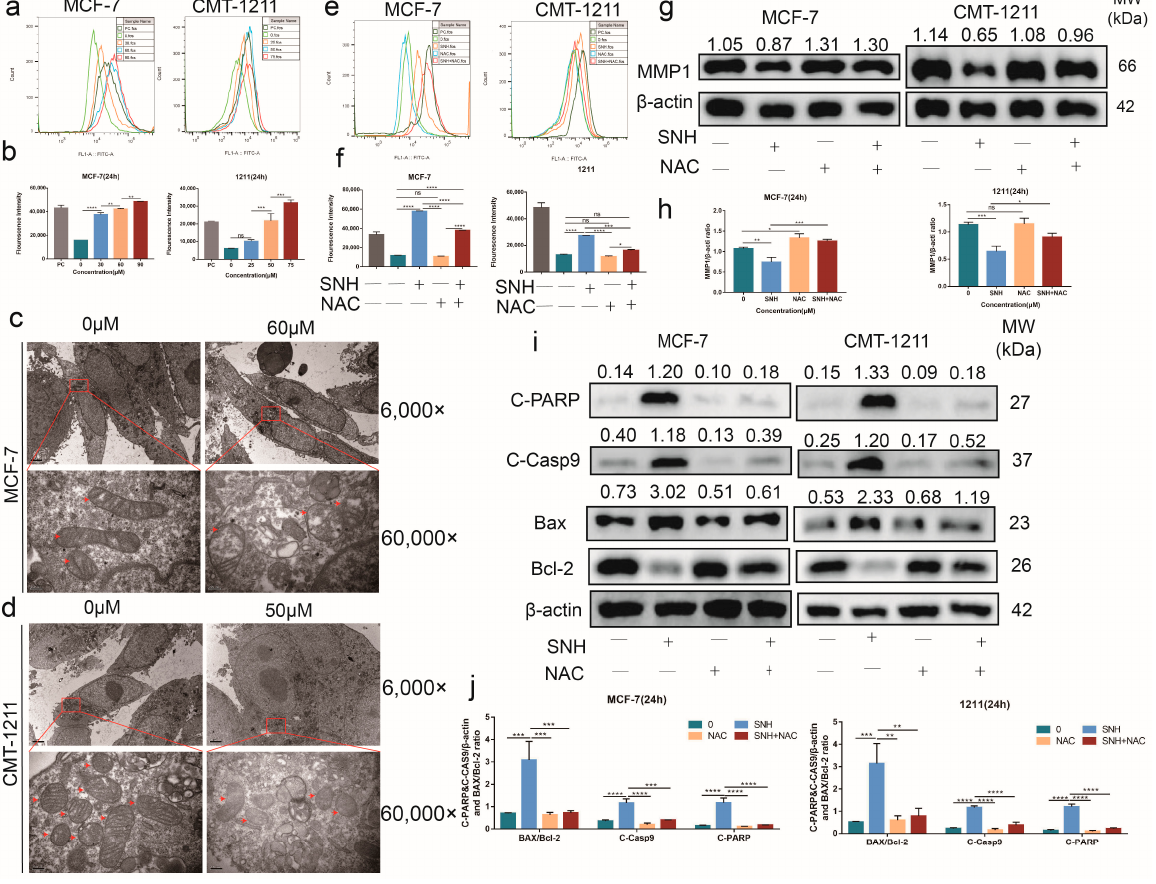
Figure 4. SNH induced apoptosis of MCF-7 and CMT-12111 by promoting the excessive accumulation of ROS. ( a , b ) Flow cytometry was used to detect the level of ROS in MCF-7 and CMT-1211 after treatment with different concentrations of SNH. ( c , d ) TEM was used to observe the mitochondria of MCF-7 and CMT-1211 after treatment with different concentrations of SNH. Red boxes and red arrows pointed to mitochondria. 6000 × Bar: 2 µ M; 60,000 × Bar: 200 nm. ( e , f ) After treatment with 0 mM, NAC (10 mM), SNH (60 µ M in MCF-7, 50 µ M in CMT-1211), and NAC combined with SNH, flow cytometry was used to detect the level of ROS in MCF-7 and CMT-1211. ( g , h ) After treatment with 0 µ M, NAC (10 mM), SNH (60 µ M in MCF-7, 50 µ M in CMT-1211), and NAC combined with SNH, the expression levels of MMP1 were analyzed using Western blot. The western blot original images in the Figure S1. ( i , j ) After treatment with 0 µ M, NAC (10 mM), SNH (60 µ M in MCF-7, 50 µ M in CMT-1211), and NAC combined with SNH, Western blot was applied to analyze the expression levels of apoptosis-related proteins BAX, Bcl-2, cleaved caspase-9, and cleaved PARP in MCF-7 and CMT-1211. All results are expressed as mean ± SD of three independent experiments. * p < 0.05, ** p < 0.01, *** p < 0.001, **** p < 0.0001, ns = not